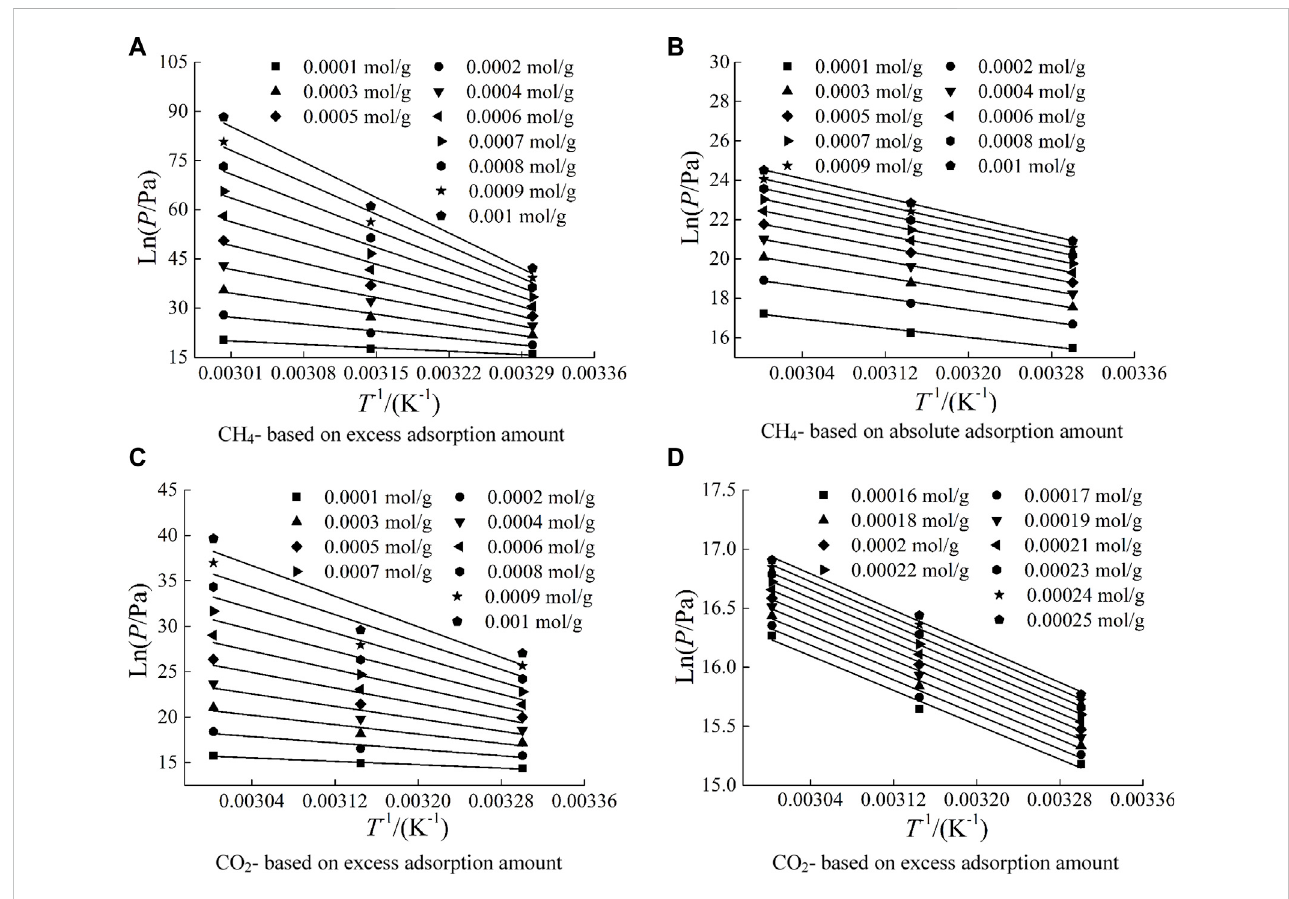
FIGURE 8 The fi tting curve of ln p-T -1 under different types of adsorption capacity.